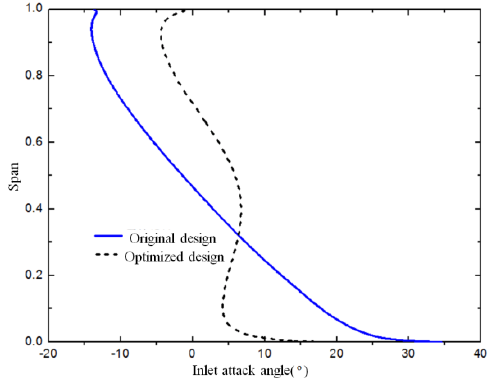
Figure 9. Inlet attack angle distribution of the vaned diffuser in the optimized design.